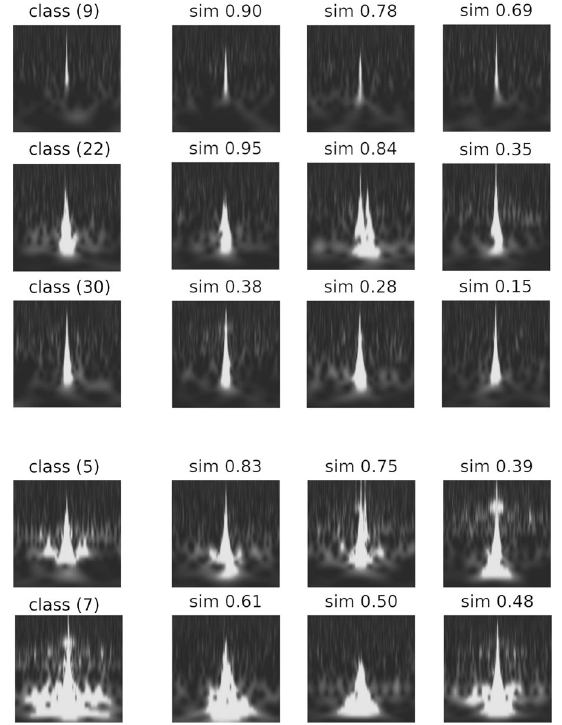
Figure 5. Representative images and images similar to unsupervised learning. Considering the figure, classes (9), (22), and (30) are separated from the ‘‘Blip” class, and classes (5) and (7) are separated from the “Koi_Fish” class. The representative images in the left column are sampled randomly from the images classified in class ( i ) using unsupervised learning. The similar images in the other columns are sorted in a descending order and are sampled randomly from the cosine similarity (a value at the top of an image), considering the representative